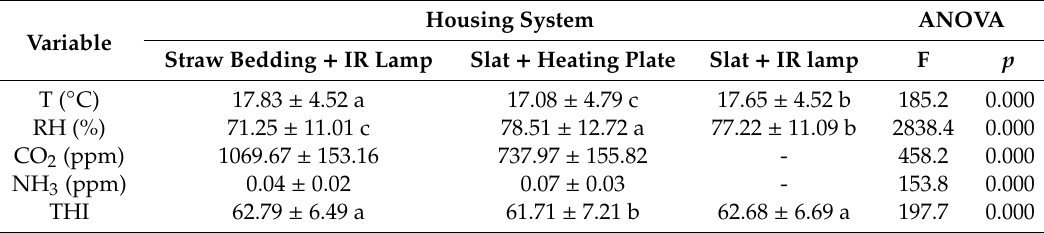
Table 2. ANOVA of the environmental parameters as a function of the lamb housing system. For each environmental variable, the values labeled with di ff erent lowercase letters are statistically di ff erent according to the Tukey’s test ( p <